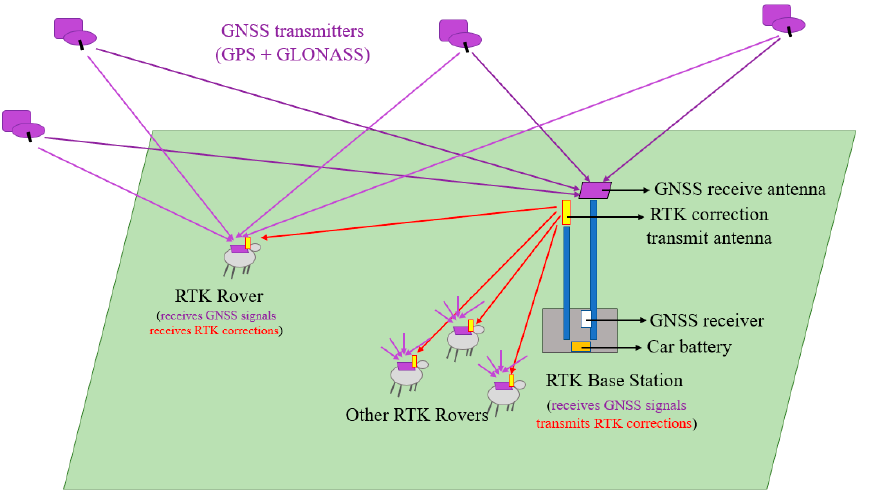
Figure 2. System operational diagram showing GNSS satellites, the RTK base station and RTK rovers harnessed to sheep. The purple lines are the continuous GNSS signals sent to the base station, and red arrows are the computed and transmitted correction messages from base station to RTK rovers.